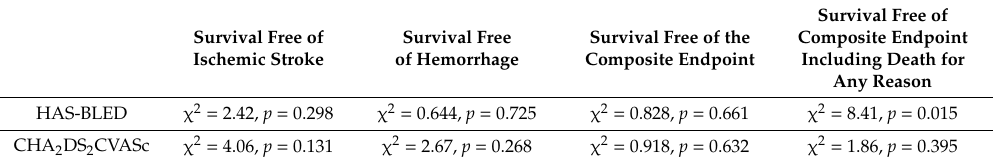
Table 2. Analysis of di ff erences for survival curves calculated for di ff erent HAS-BLED and CHA 2 DS 2 CVASc scores (log-rank test). Survival Free of Composite Endpoint Survival Free of Survival Free Survival Free of the Including Death for Ischemic Stroke of Hemorrhage Composite Endpoint Any Reason HAS-BLED χ 2 = 2.42, p = 0.298 χ 2 = 0.644, p = 0.725 CHA 2 DS 2 CVASc